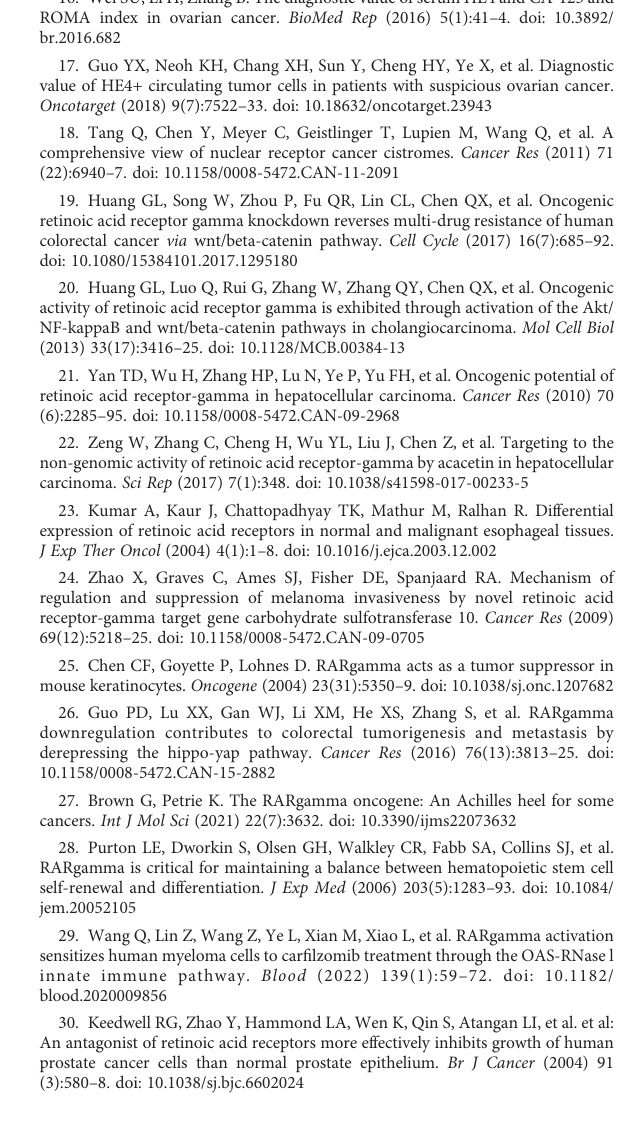
SUPPLEMENTARY FIGURE 1 The top 10 biological pathways negtively correlated with high RARG